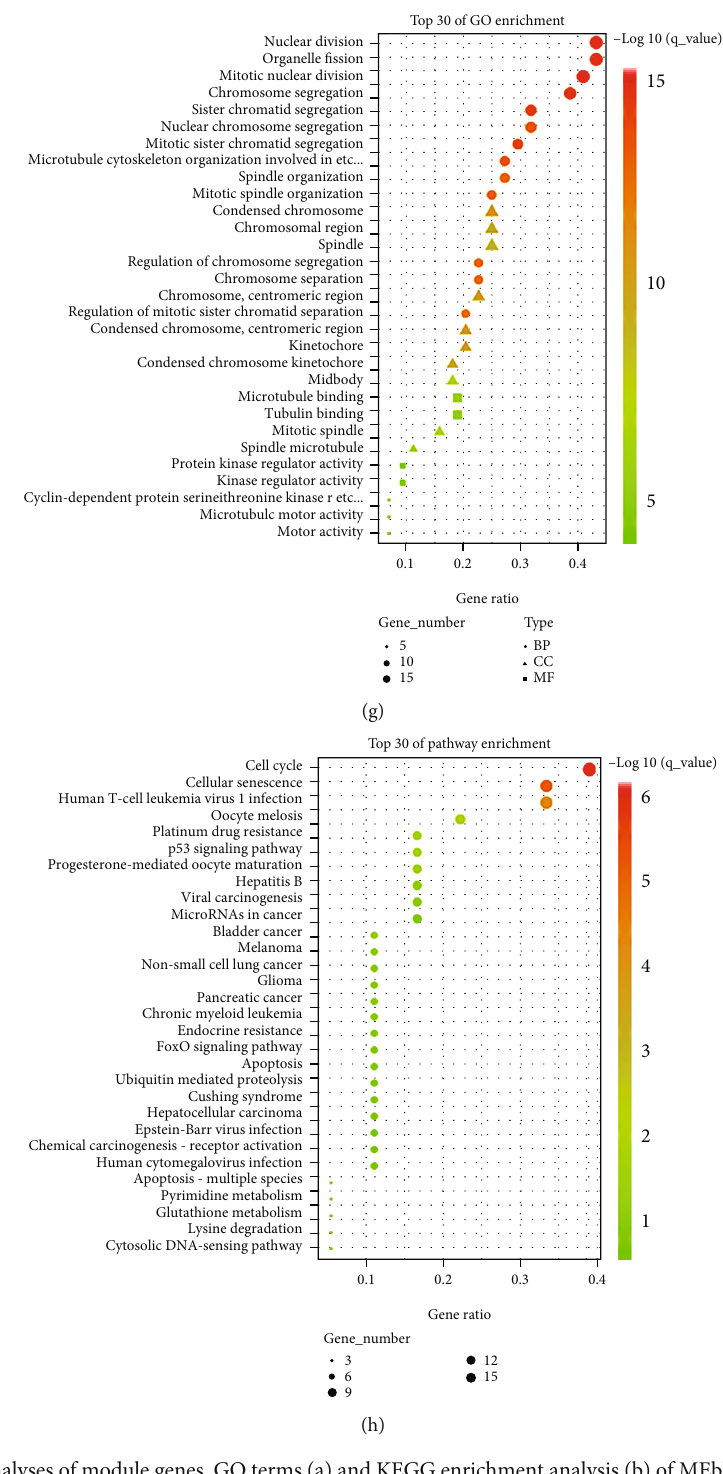
Figure 4: GO and KEGG analyses of module genes. GO terms (a) and KEGG enrichment analysis (b) of MEblack module. GO terms (c) and KEGG enrichment analysis (d) of MEyellow module. GO terms (e) and KEGG enrichment analysis (f) of MEgreen modules. GO terms (g) and KEGG enrichment analysis (h) of MEmagenta